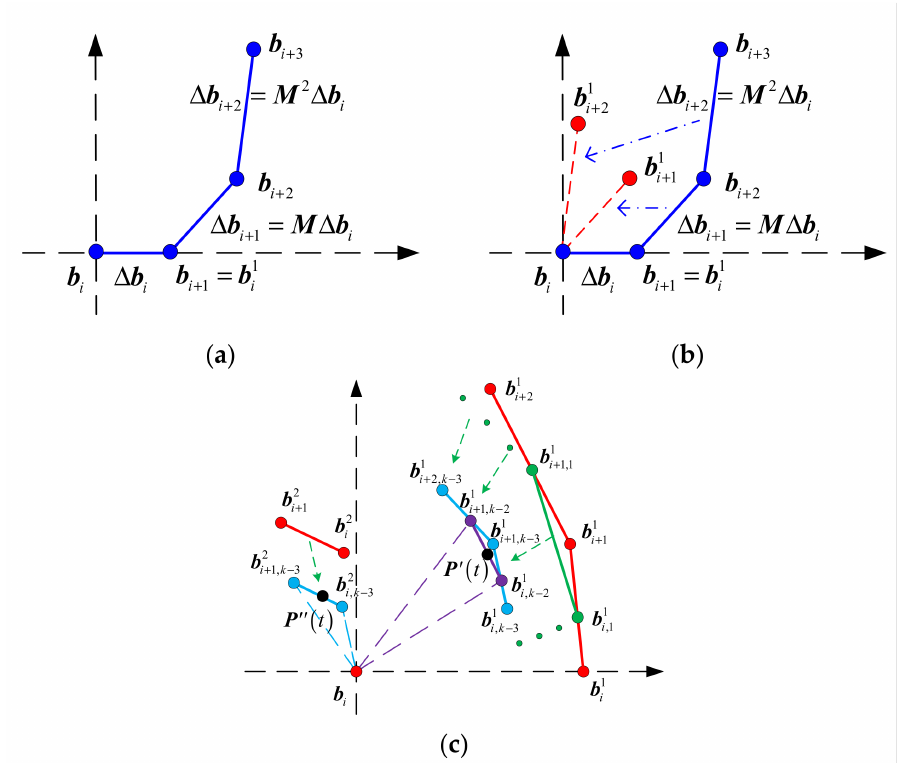
Figure 1. The construction of typical B é zier curves. ( a ) Control edges are designed according to de Casteljau